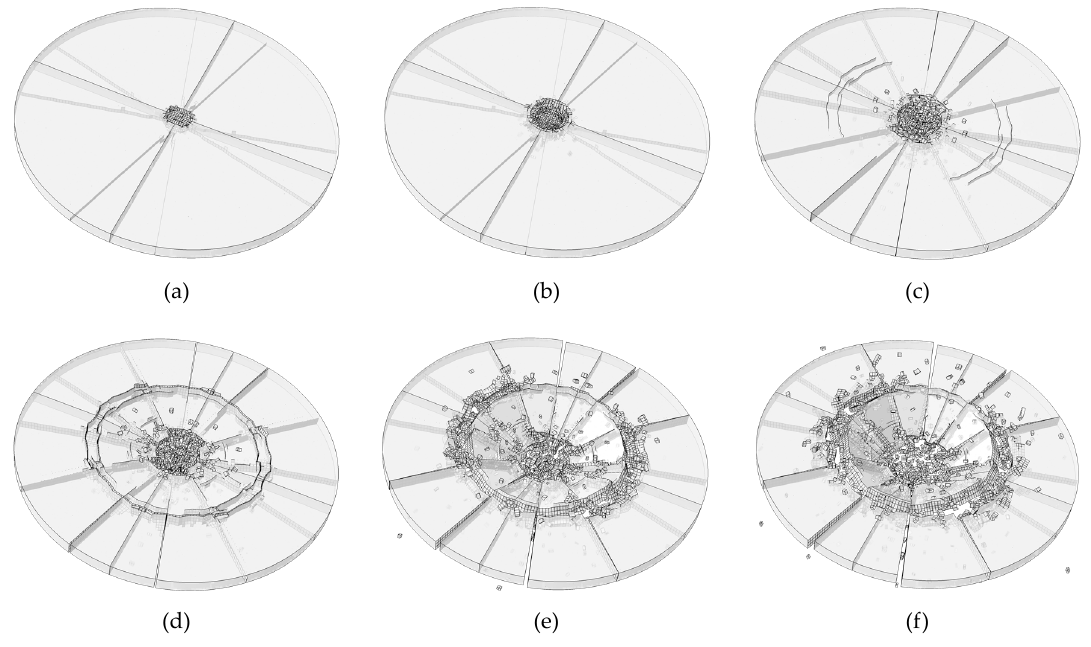
Figure 10. Failure process of the plate ( a ) 0.5 ms; ( b ) 1.0 ms; ( c ) 2.0 ms; ( d ) 2.5 ms; ( e ) 4.0 ms; ( f ) 5.0